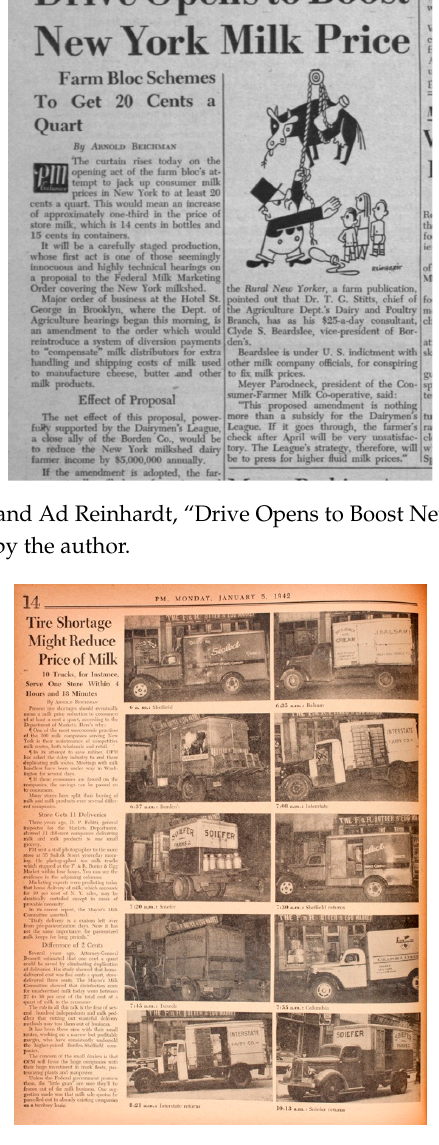
Figure 3. Arnold Beichman and unnamed photographer, “Tire Shortage Might Reduce Price of Milk”, PM , 5 January 1942. Image Courtesy of the International Center of